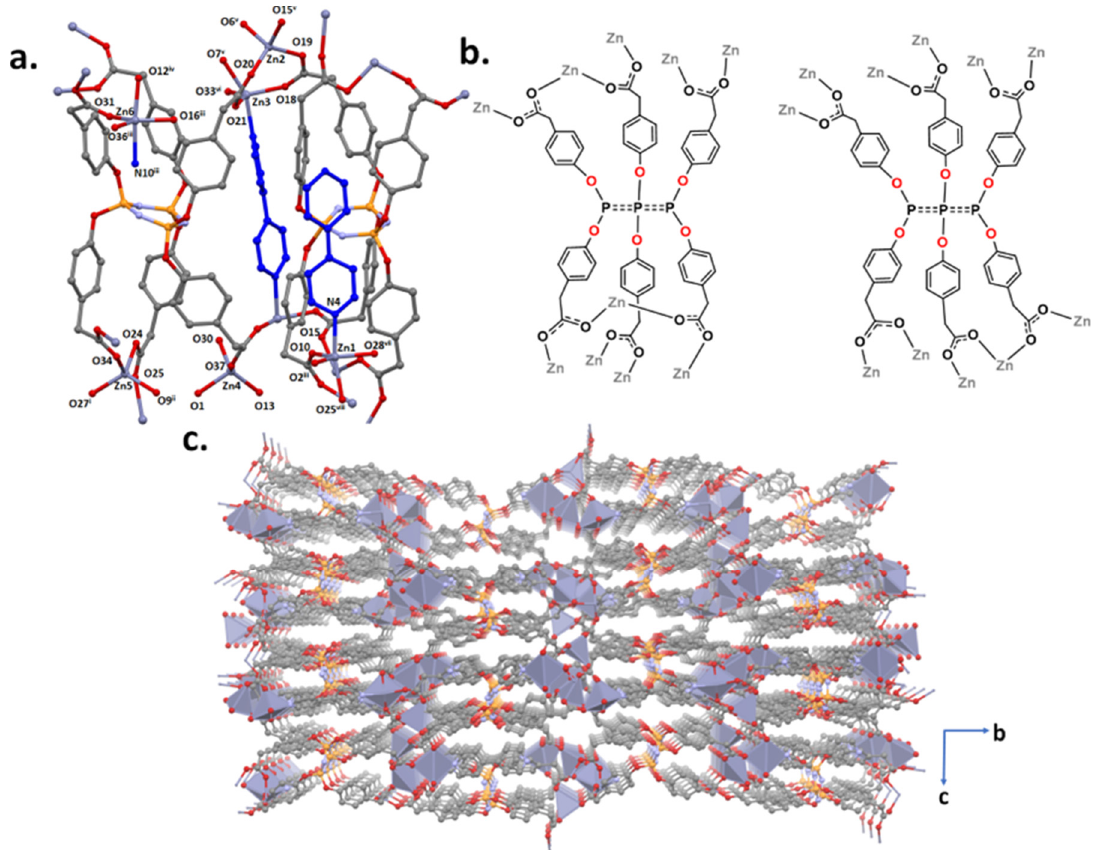
Figure 4. ( a ) Ball-stick representation of crystal structure of GTU-3. All H-atoms were omitted for clar- ity, and 4,4 (cid:48) -bpy units are shown in blue. ( b ) Coordination modes of deprotonated ligand (L). ( c ) View of three-dimensional coordination polymer looking down the a-axis. Symmetry transformations used to generate equivalent atoms: (i): 1.5-x,-1/2+y,1/2-z; (ii): 1-x,1-y,1-z; (iii): -1/2+x,1.5-y,-1/2+z: (iv): 1-x,2-y,1-z: (v): 1.5-x,1/2+y,1.5-z: (vi): 1/2+x,1.5-y,1/2+z: (vii): -1/2+x,1.5-y,1/2+z: (viii):